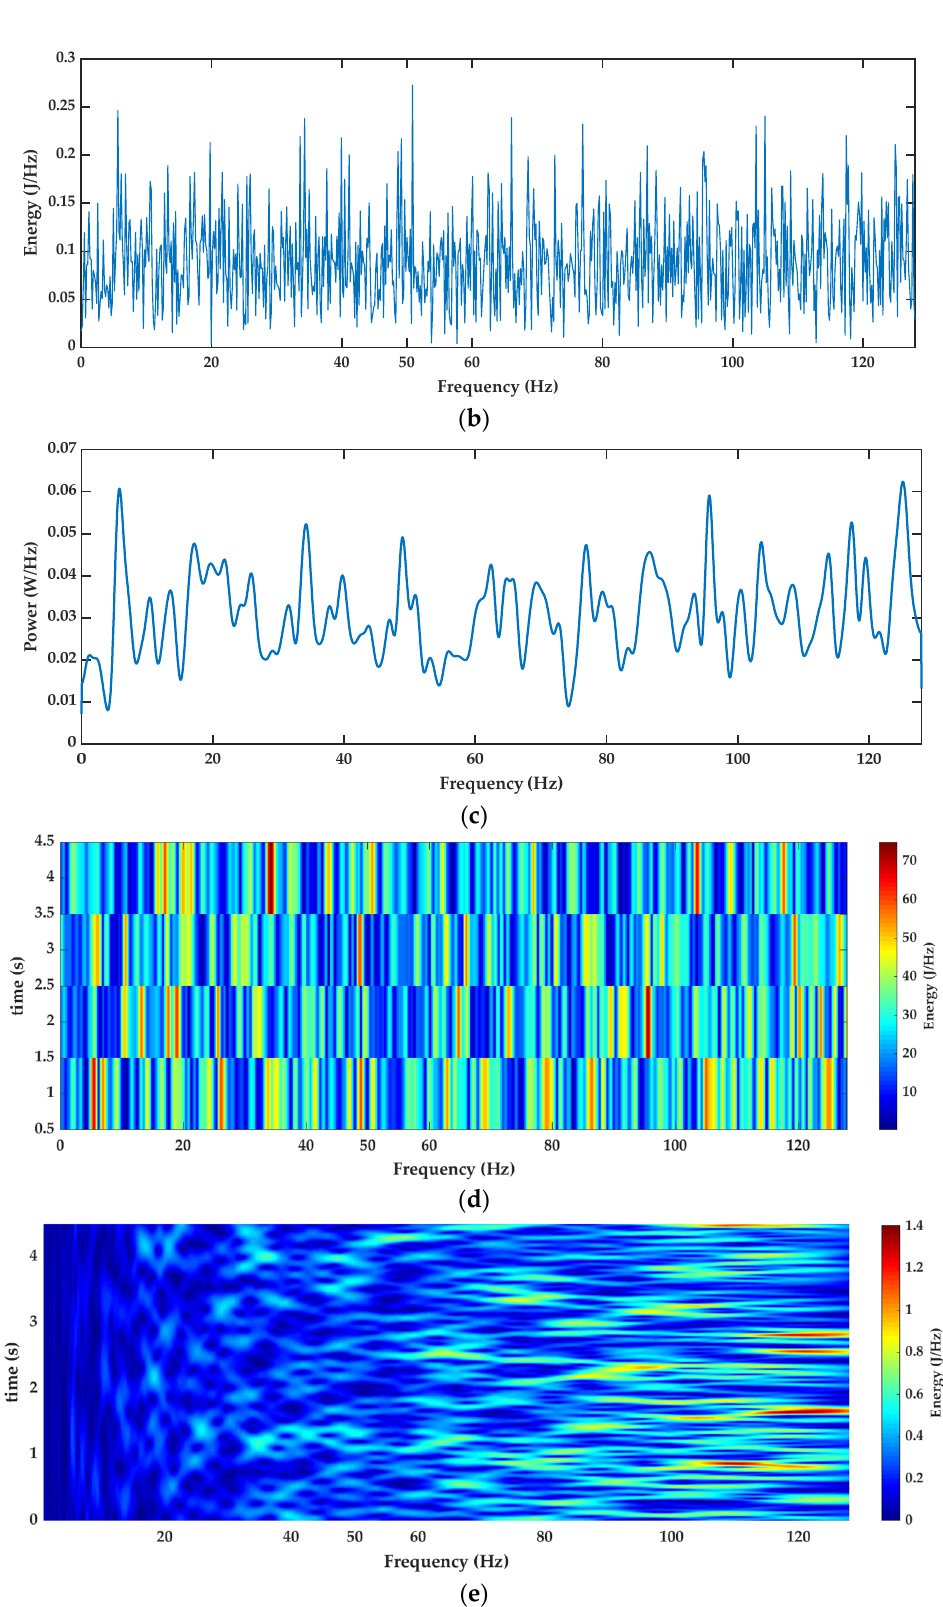
Figure 6. Results for the second scenario (with noise). ( a ) Error estimation 0.8%, ( b ) Error estimation 1.72%, ( c ) Error estimation N/A, ( d ) Error estimation N/A, ( e ) Error estimation N/A.